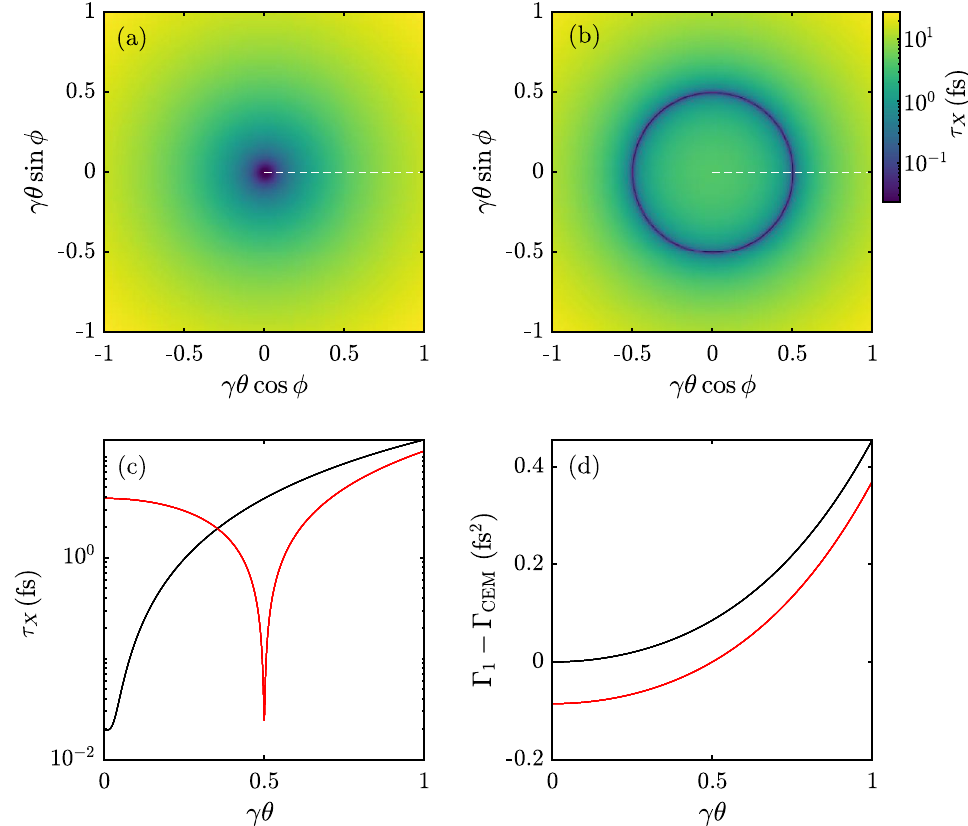
Figure 2. An 11 fs CEM irradiated by a GDD-matched 5 ps laser pulse. ( a ) Pulse length distribution for on axis matching. ( b ) Pulse length distribution for off axis matching. ( c ) Pulse length along white dashed line for on axis (black) and off axis (red) matching. ( d ) Difference in group delay dispersion between the superradiance induced by the mirror and the single electron radiation.